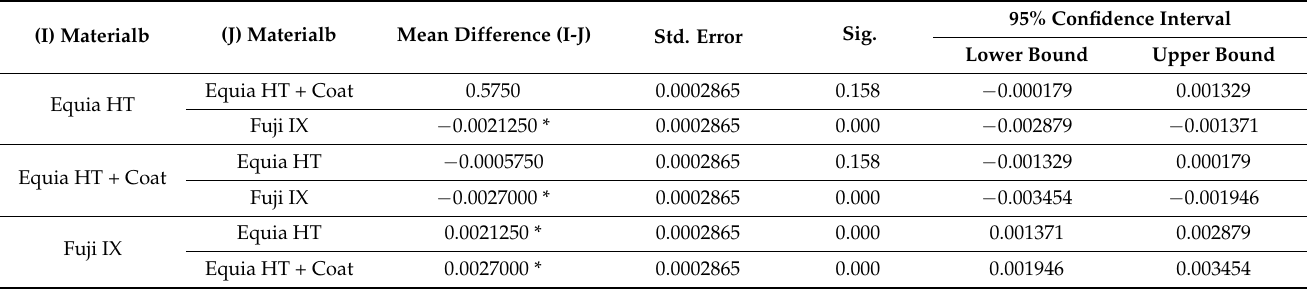
Table 3. Analysis of the effect of acid load on the wear of samples stored in distilled water. (I)